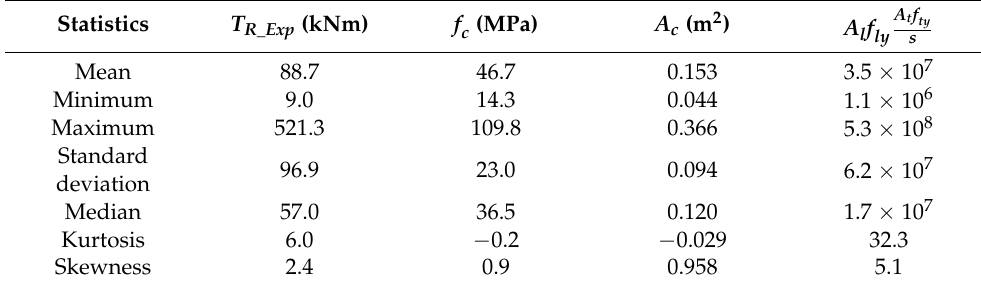
Table 2. Statistical measures of the variables for the training set.